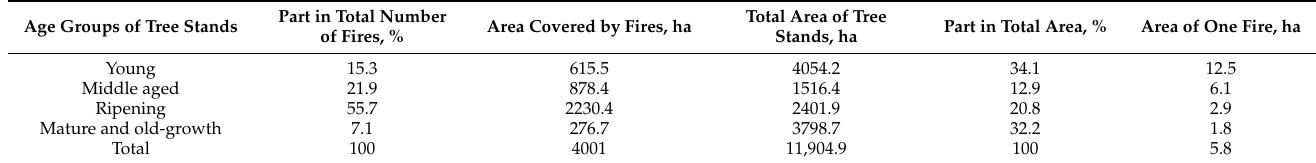
Table 2. Distribution by age groups of forest areas covered by